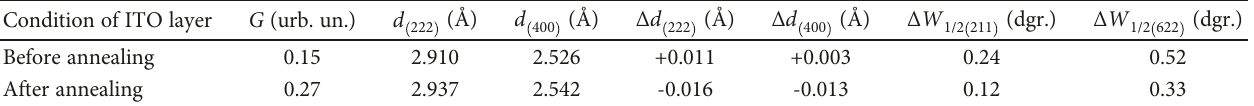
Table 2: E ff ect of annealing in air on the structure characteristics of ITO fi lms formed on polyimide substrates at a temperature of 430 ° C. Condition of ITO layer G (urb. un.)